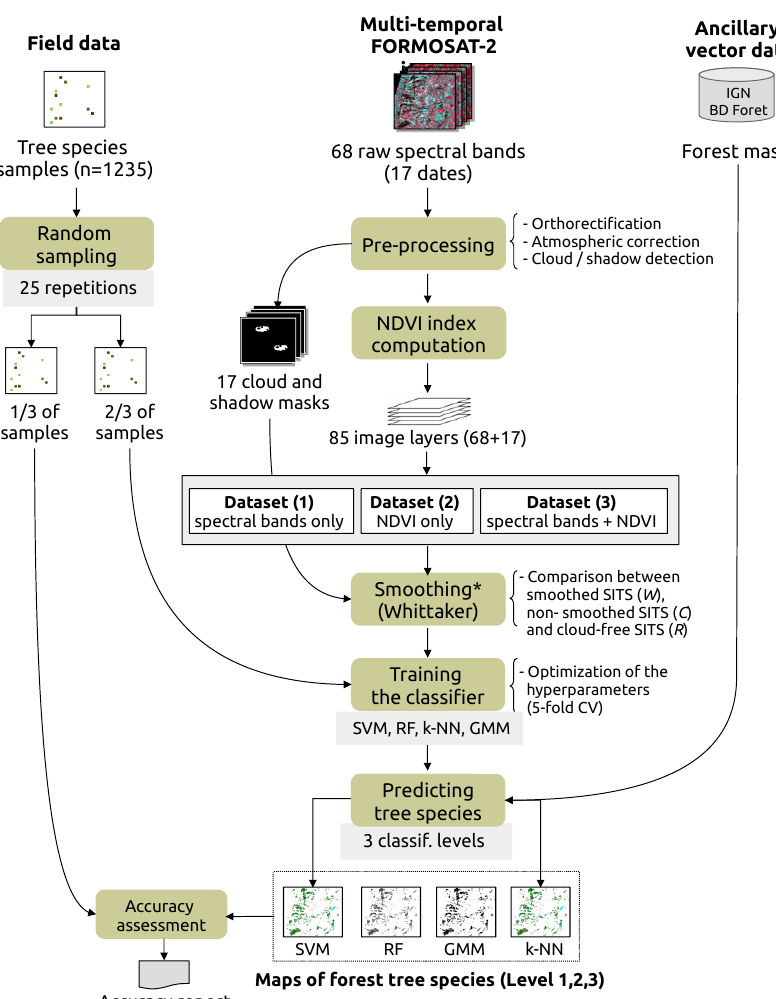
Figure 3. Tree species classification process of the Formosat-2 satellite image time series. Note that the smoothing step is applied on the three datasets separately